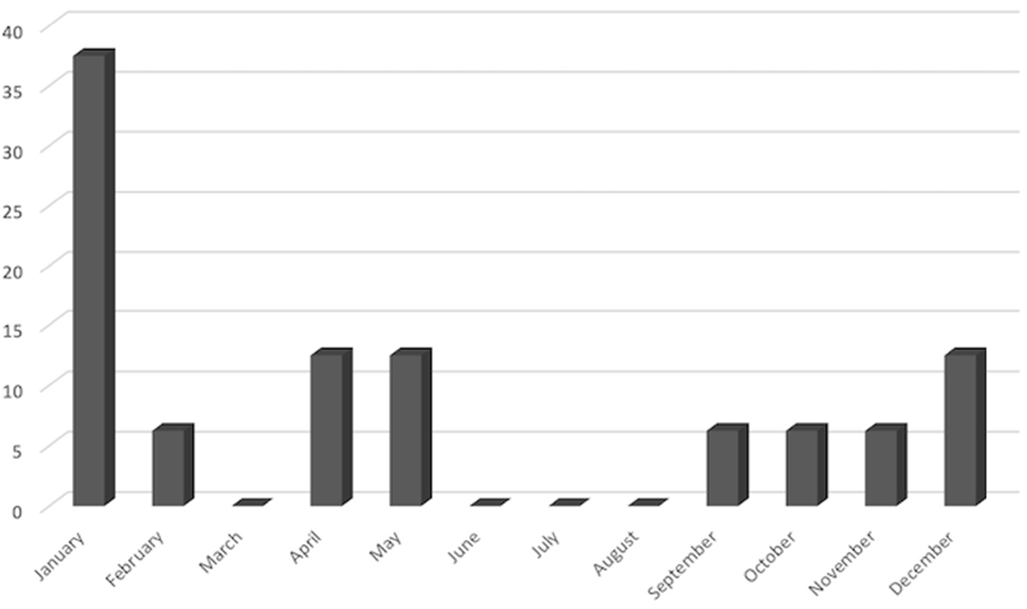
Figure 4. Monthly distribution of knee pain onset.